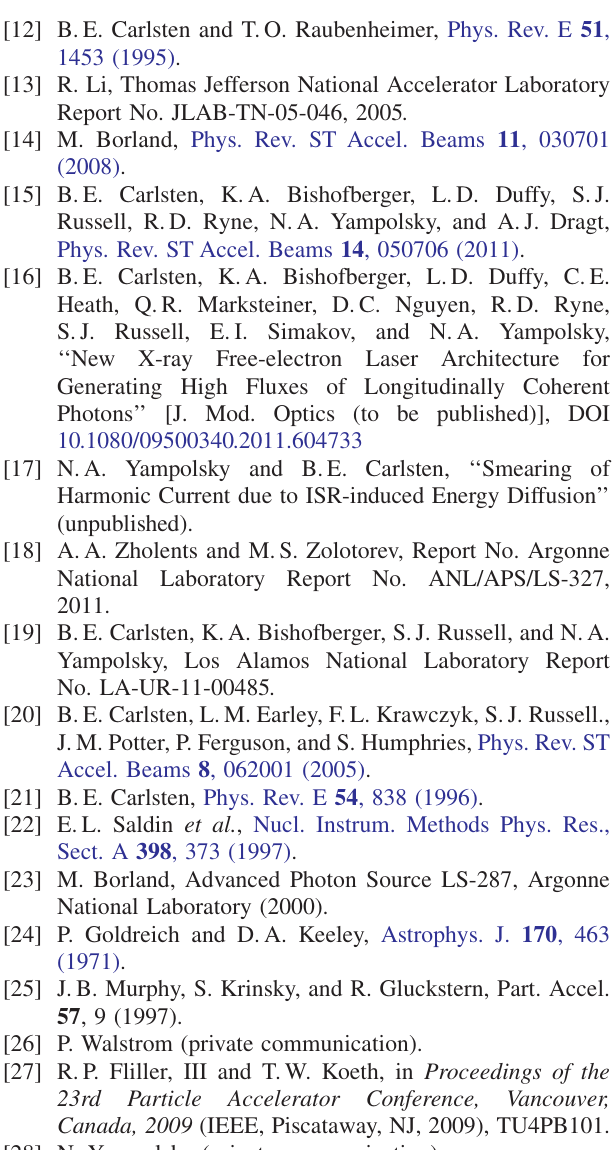
FIG. 13. Transverse-to-longitudinal emittance exchange optic with optics for negative drift lengths between the